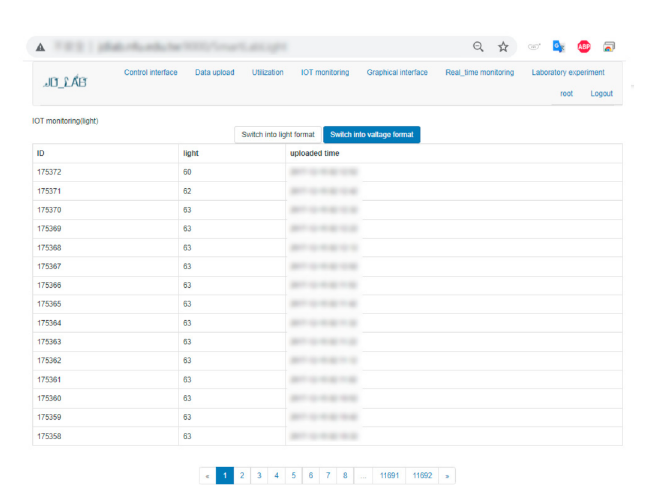
Figure 18. IoT sensor data-collection interface.